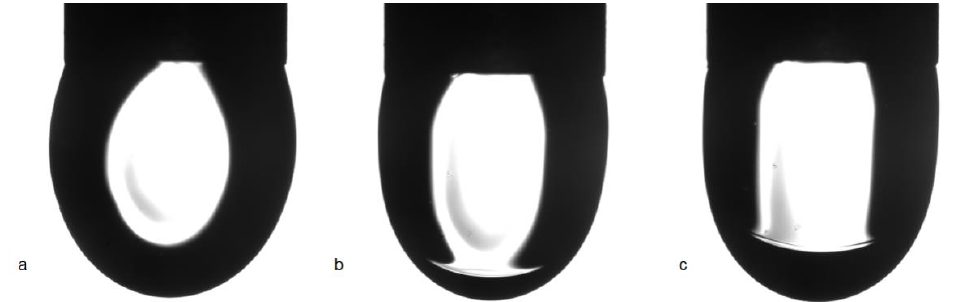
Figure 9. Images of 1 µmol/L aqueous C 13 DMPO solution drops formed in hexane vapor at different times after drop formation: ( a ) 516 s, ( b ) 3522 s, ( c ) 6535 s.